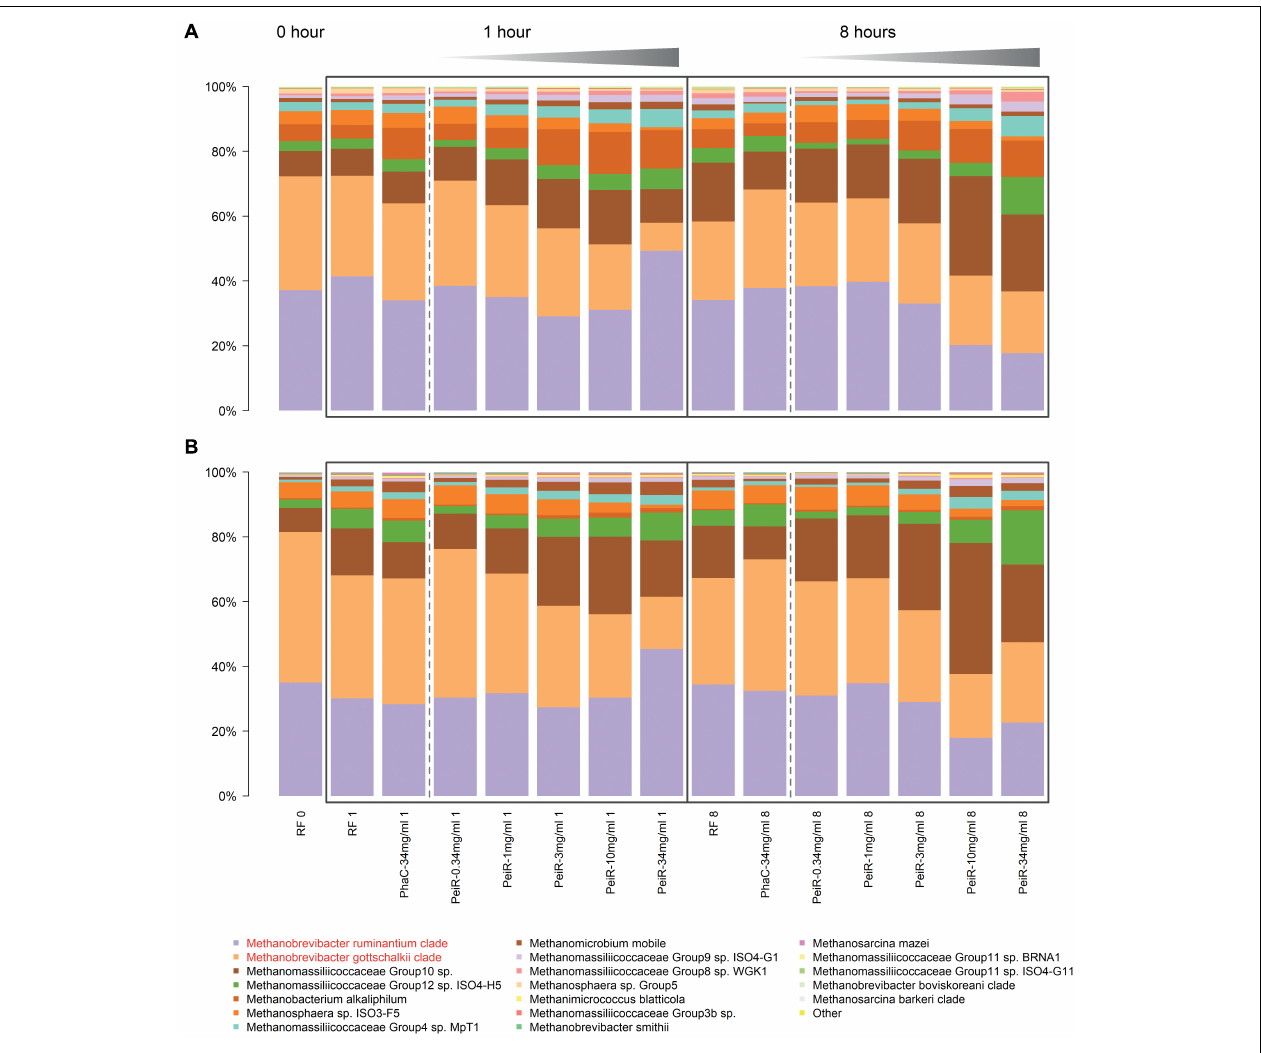
FIGURE 3 | Relative changes in the archaeal community over time in a rumen batch model. In vitro batch fermentations were set up with rumen fluid inoculum sampled from two different cows, #7305 (A) and #39 (B) , respectively. The base state of the rumen archaeal community at t = 0 h (“RF 0”) is shown on the left. Control groups (Rumen Fluid only) and non-functionalized nanoparticles (“PhaC”) are presented at each sample time point. Non-functionalized nanoparticles were dosed at the highest corresponding dual-fusion nanoparticle concentration of 34 mg/ml. RF, Rumen fluid (control); PhaC, non-functionalized nanoparticles; PeiR, Dual-fusion PeiR nanoparticles. M. ruminantium (light purple) and M. gottschalkii (orange) clades are highlighted in red in the legend. Black boxes indicate the sample intervals of 1 and 8 h. Gray gradients visualize the increasing treatment dosages from 0.34 to 34 mg/ml. For each community profile, the top 20 most abundant taxa are presented, comprising > 99% of all